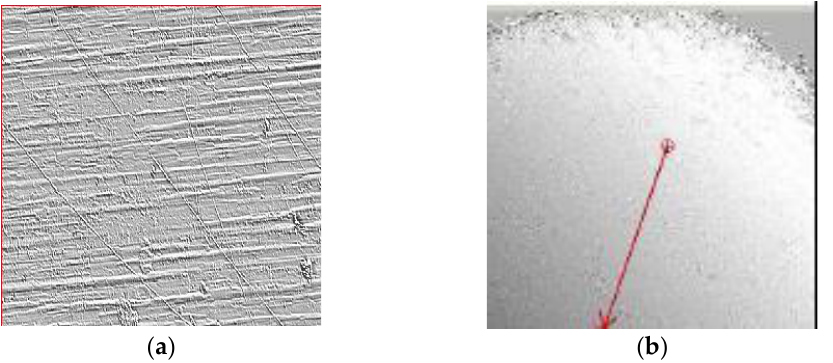
Figure 13. Results of the laser scan profilometry of the surfaces: ( a ) aluminum plate; ( b ) steel ball: the red arrow marks the direction and length of